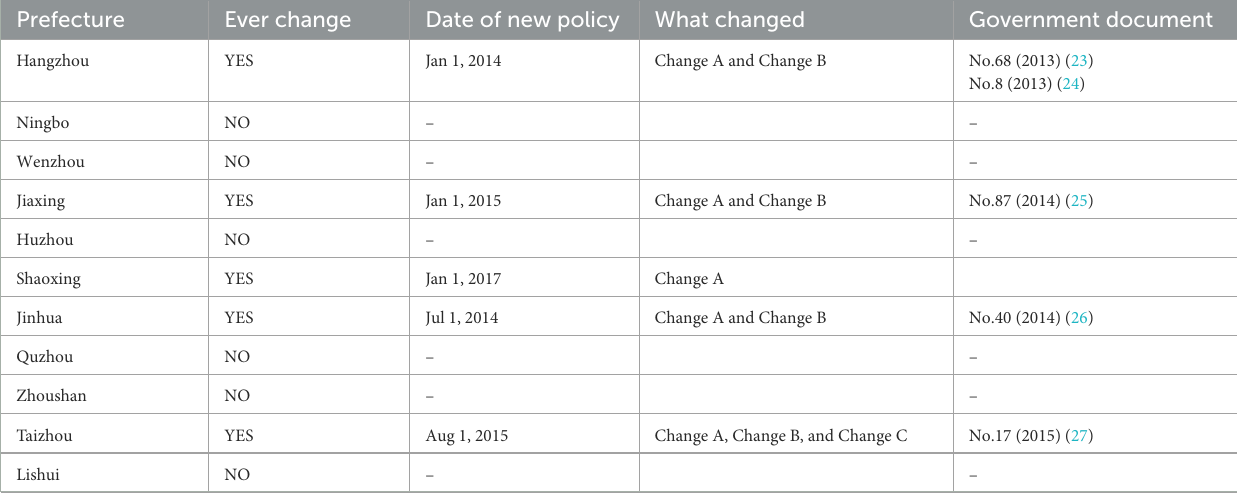
TABLE 1 Changes in Urban Employees’ Basic Medical Insurance reimbursement policies between 2013 and 2017 in prefecture-level cities in the Zhejiang province.